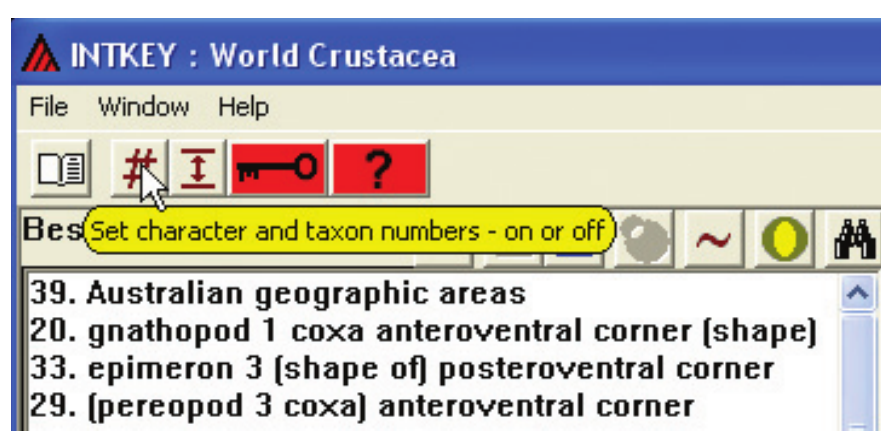
Figure 38. Set character and taxon numbers